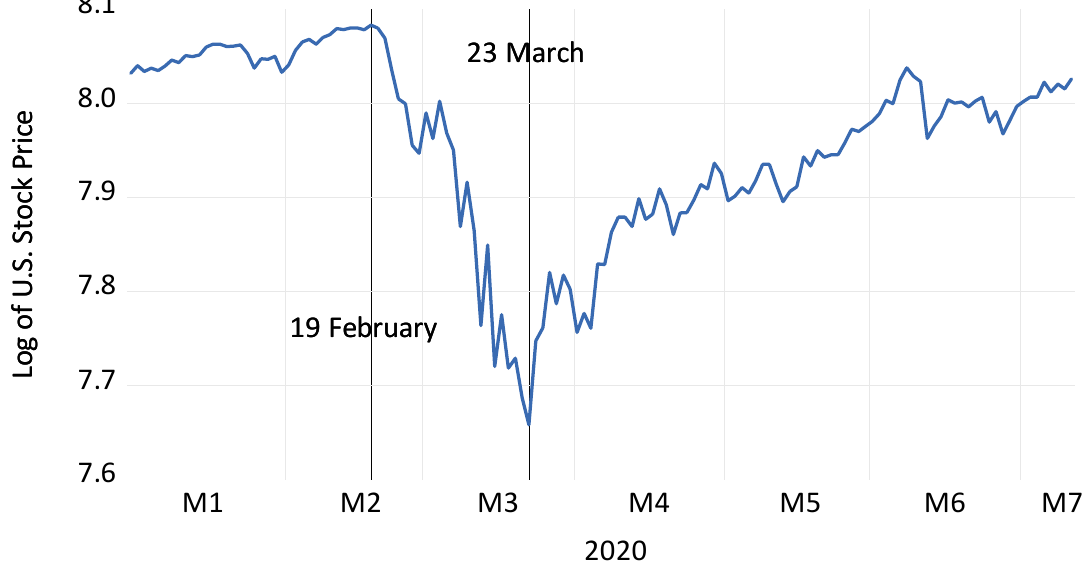
Figure 1. U.S. aggregate stock prices. Source: Datastream database.